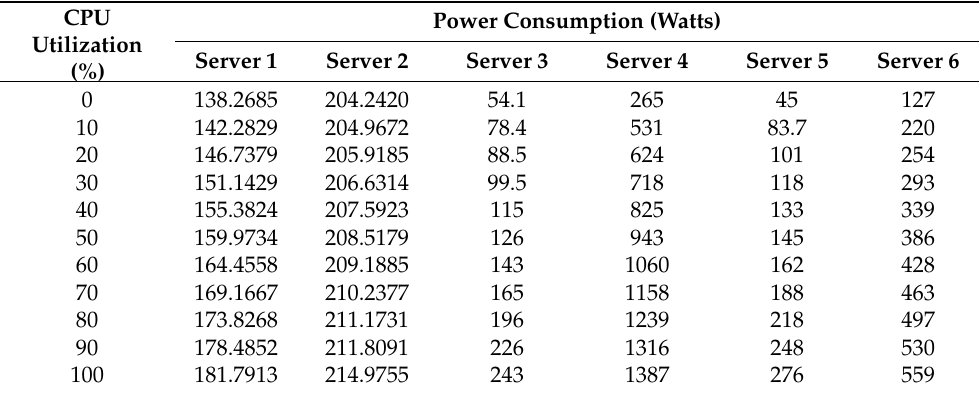
Table 5. CPU utilization and corresponding power consumption for the servers used in the experi-